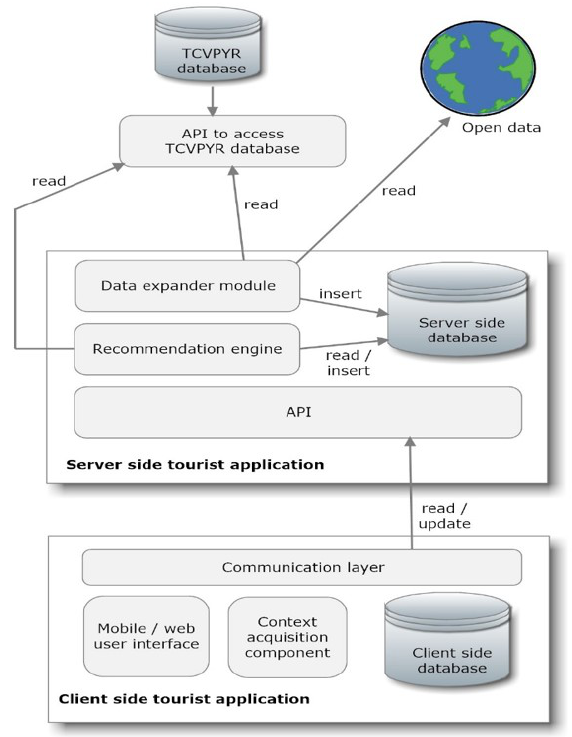
Figure 7. The Tourist